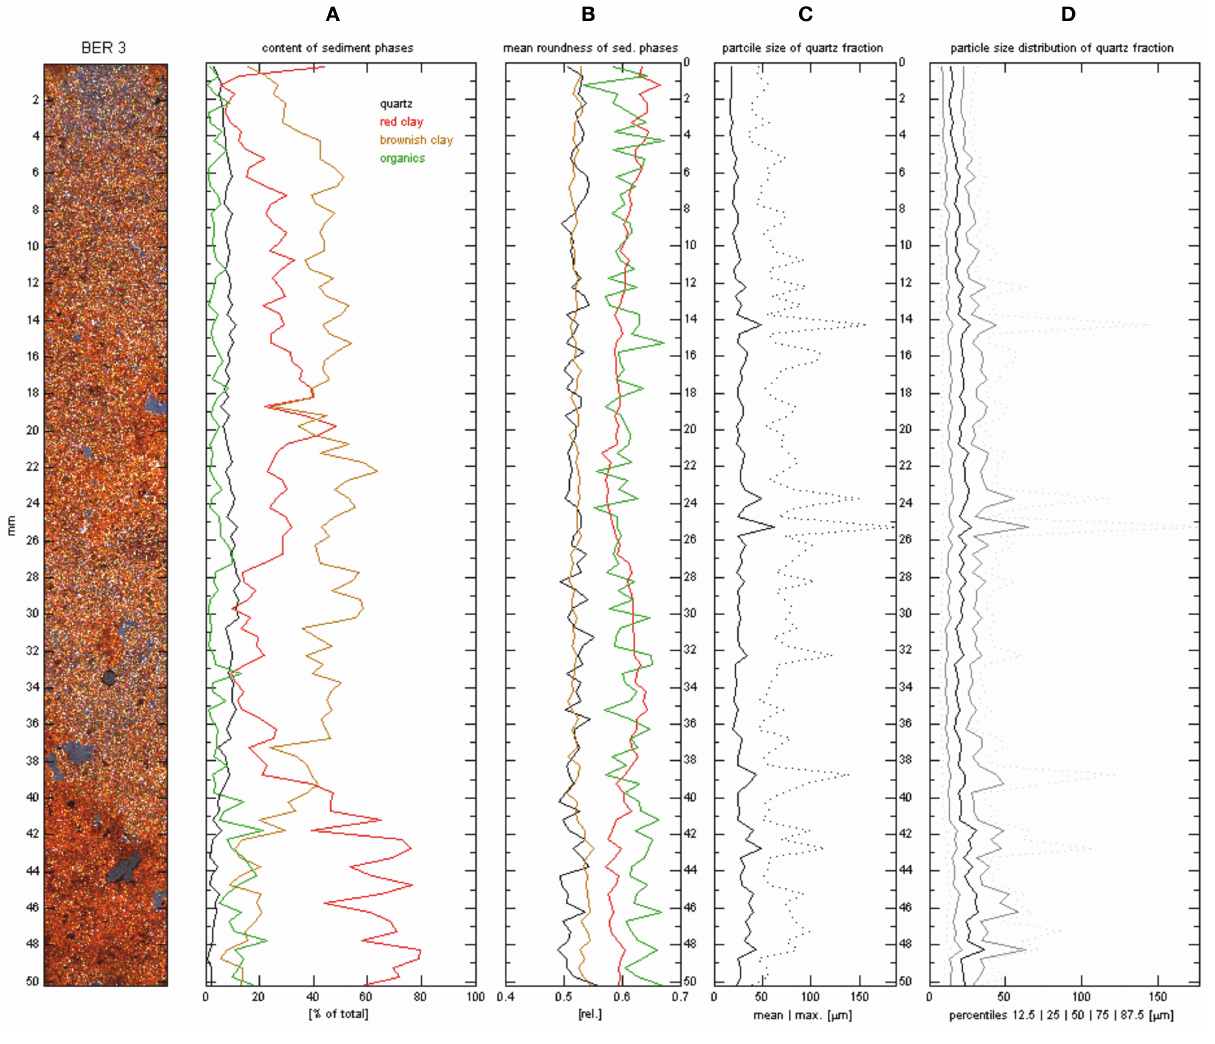
FIGURE 2 | The RADIUS detection system of red clay samples from fissure BER (Beremend, see in Figure 1C ). (A) Content of sediment phases; (B) Mean roundness of sediment phases; (C) Particle size of quartz fraction; (D) Particle size distribution of quartz